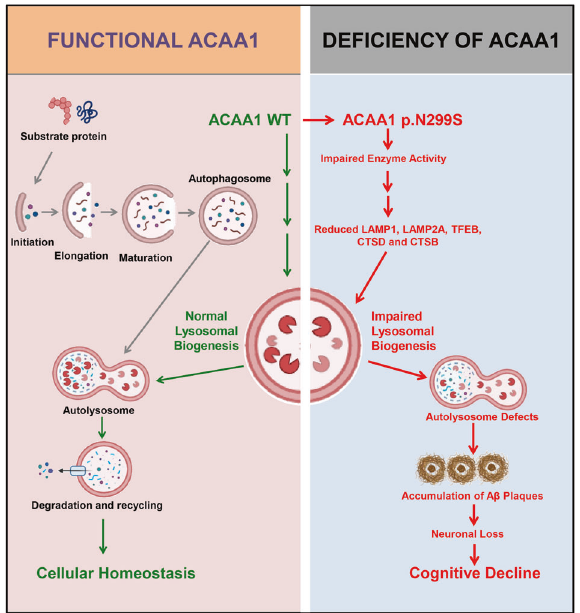
Fig. 8 A proposed role of the ACAA1 p.N299S-mediated lysosomal dysfunction and impaired autophagy in the development of AD. ACAA1 p.N299S has an impaired enzymatic activity, affects autophagy and lysosomal function, subsequently contributes